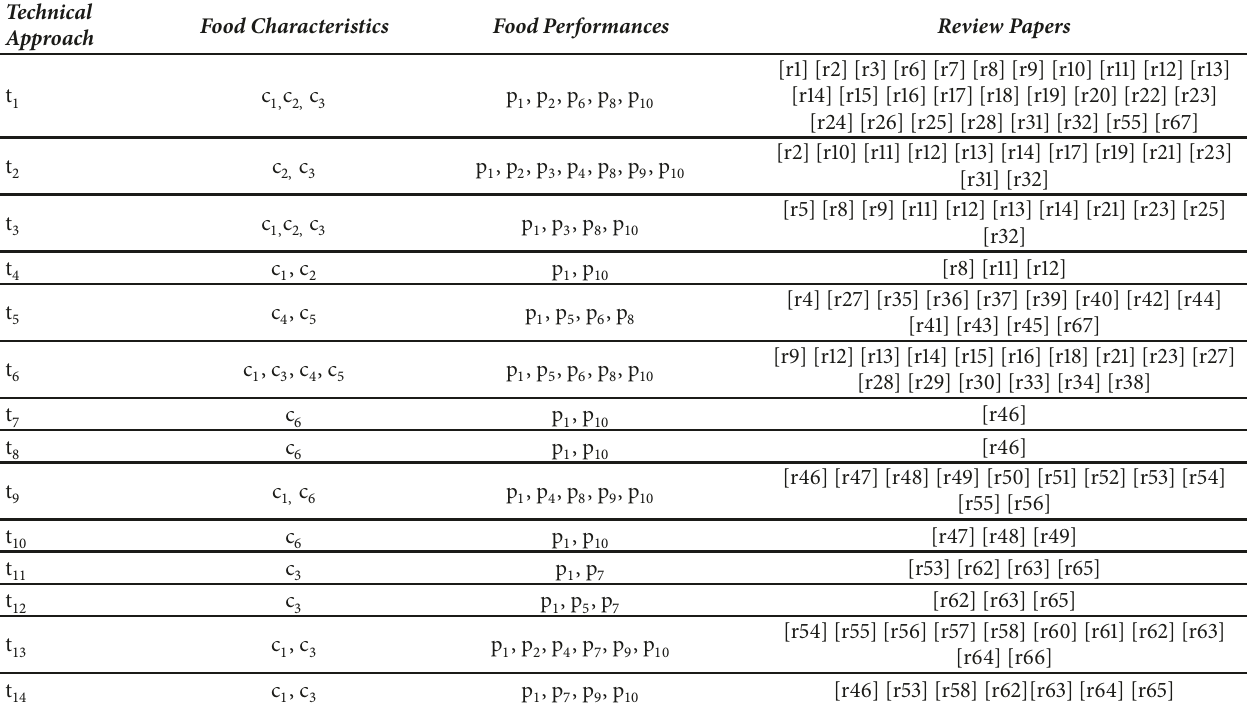
Table 4: Technological research patterns and related